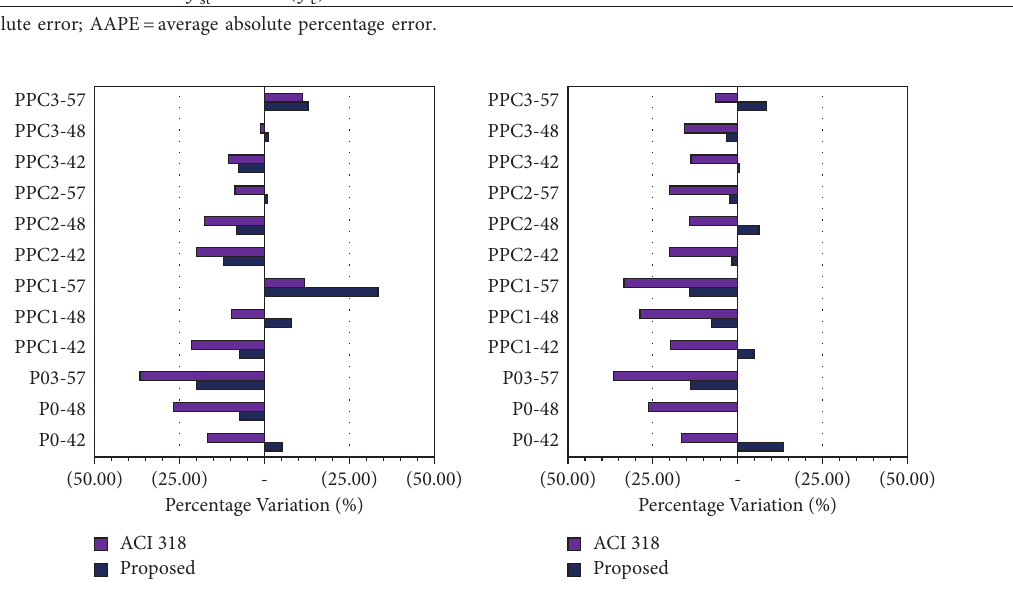
Figure 9: Percentage variation in split tensile strength with w/c ratio.